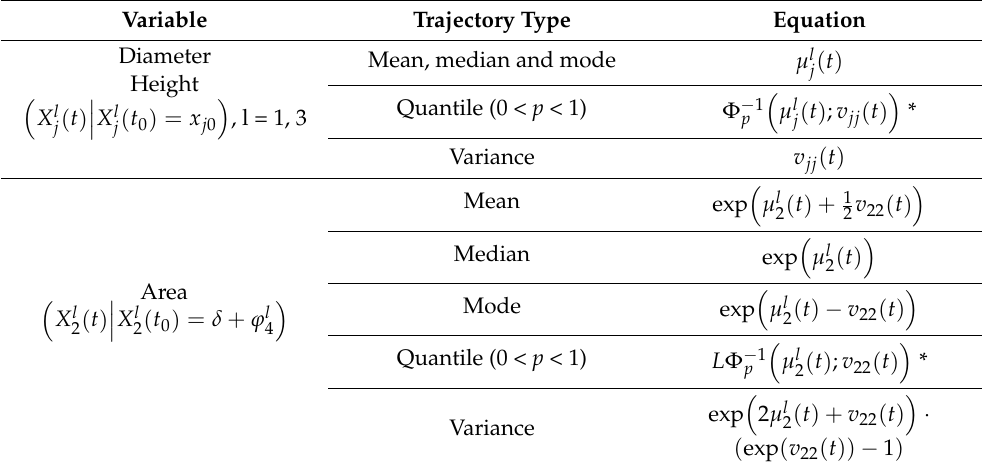
Table A1. Marginal mean, median, mode, p-quantile (0 < p < 1), and variance trends. Variable